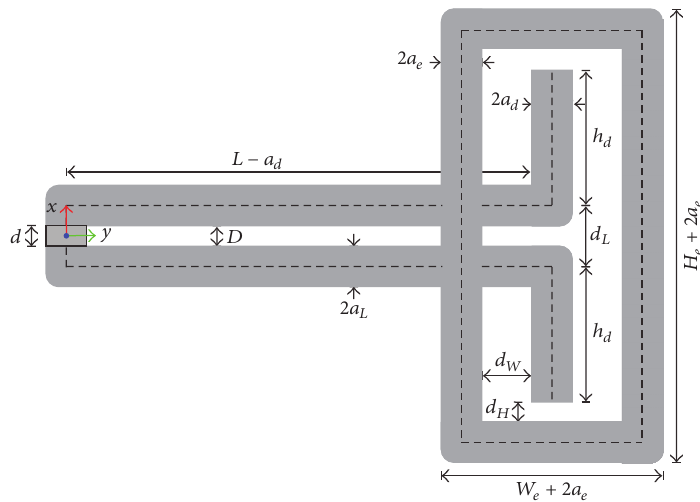
Figure 2: Top view of the cylindrical plasmonic nanocircuit.